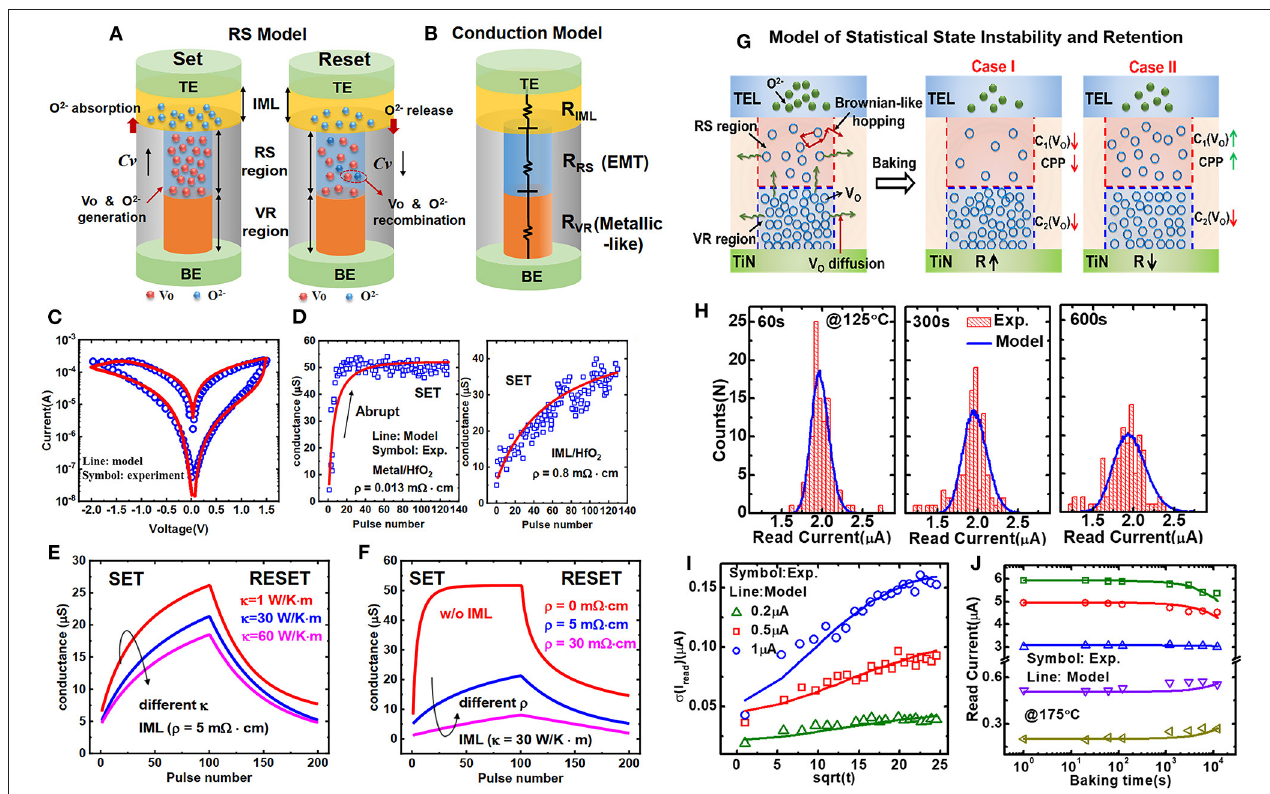
FIGURE 5 | (A) The physical switching model of the analog RRAM. (B) The conduction model. (C) The measured and calculated I–V characteristics. (D) The comparison between abrupt and gradual SET by introducing an intermediate modulation layer (IML). (E) The influence of thermal conductivity and (F) resistivity on the analog switching behavior. (G) Physical model of state instability and retention degradation. (H) Measured and calculated evolution of read current distributions. (I) Measured and calculated standard deviation of read current vs baking time. (J) Measured and calculated retention degradation for a long baking time at 175 ◦ C. Reprinted from Cai et al. (2020) and Huang et al.